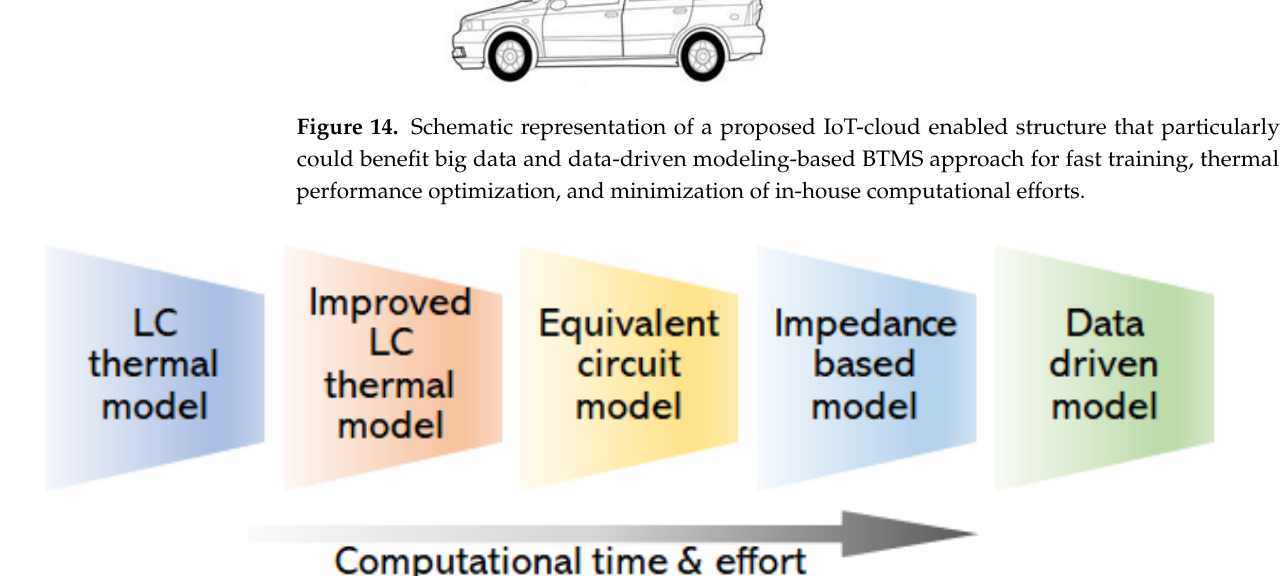
Figure 14. Schematic representation of a proposed IoT-cloud enabled structure that particularly could benefit big data and data-driven modeling-based BTMS approach for fast training, thermal performance optimization, and minimization of in-house computational efforts.